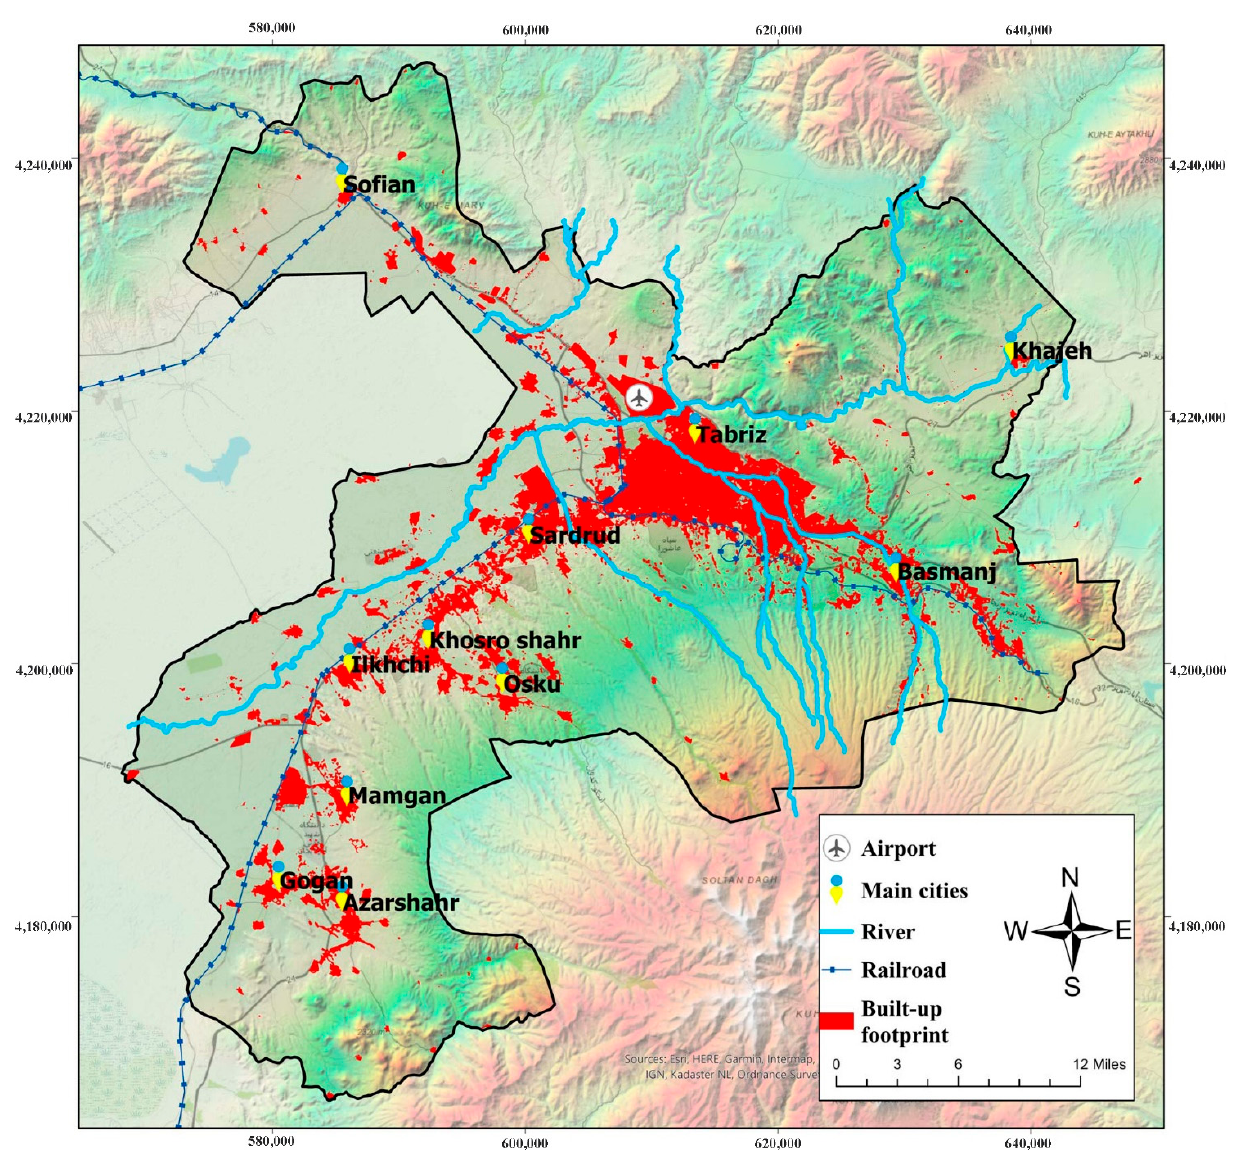
Figure 2. Location of Tabriz metropolitan area.